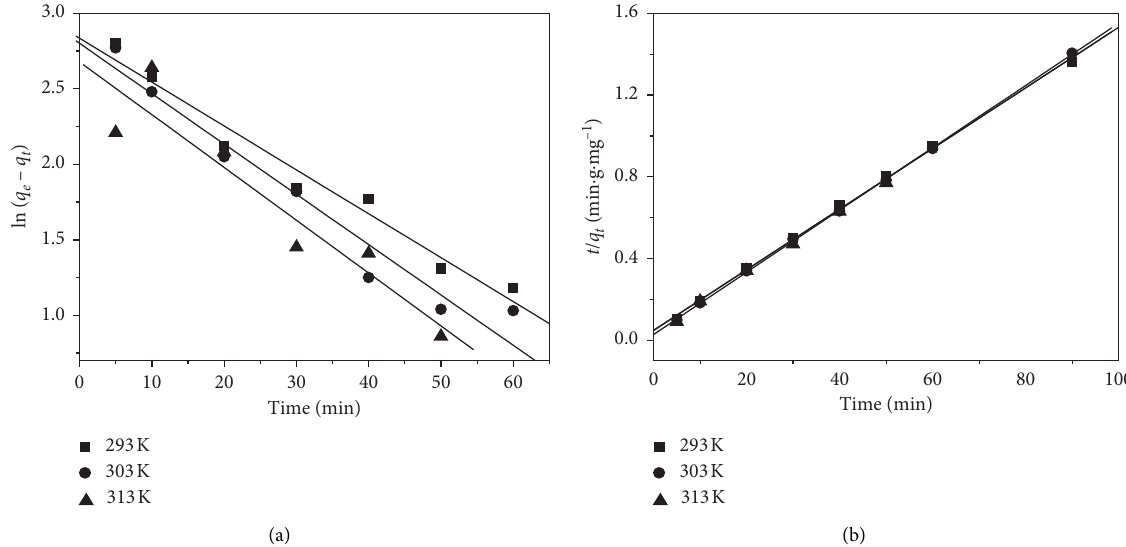
Figure 10: (a) The pseudo-first-order kinetic model and (b) pseudo-second-order kinetic model of phenol red adsorption by FeCB at different temperatures ( C o (phenol red) � 100mg L − 1 , pH 3.0, m �